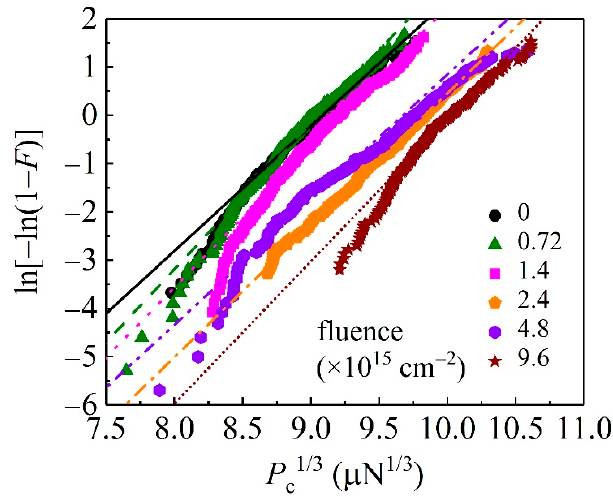
Figure 4. Extracting activation volume from experimental data using Equation (2). Straight lines are best linear fits of Equation (2) to the symbols.